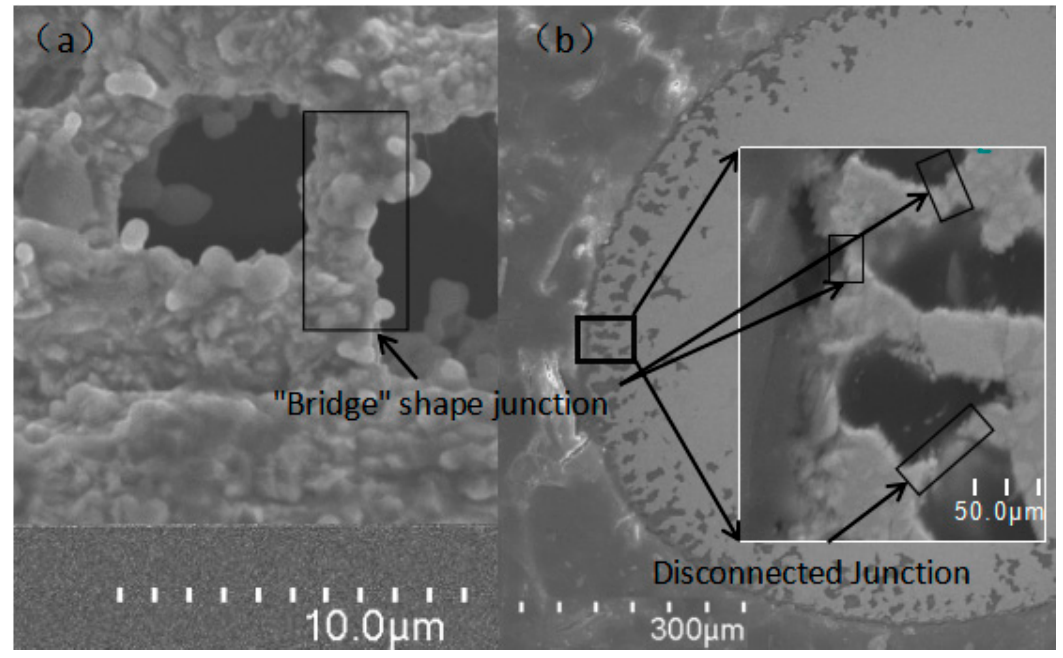
Figure 9. "Bridge" structure on IrRh25 surface after oxidation. ( a ) “Brigde” shape junction; ( b ) Disconnected junction.